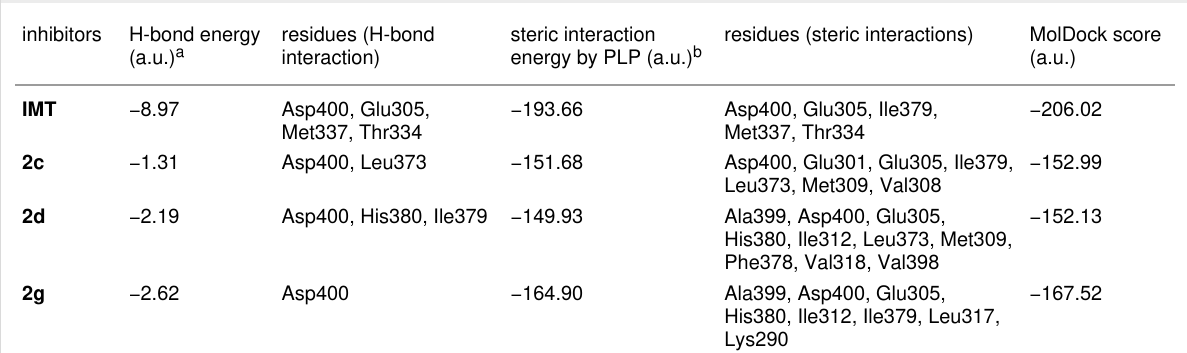
Table 2: Summary of the interactions of each inhibitor and imatinib with the tyrosine kinase BCR-Abl-1 model.